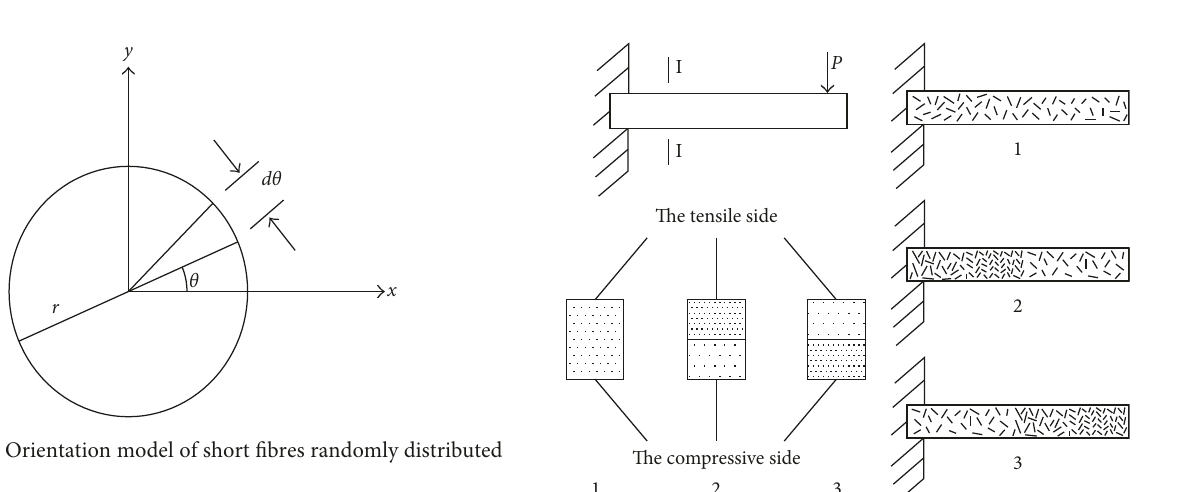
Figure 9: Model of the steel fibre orientation. (a) Model of randomly placed steel fibres in three-dimensional coordinate system. (b) Model of randomly placed steel fibres in spherical coordinate system.